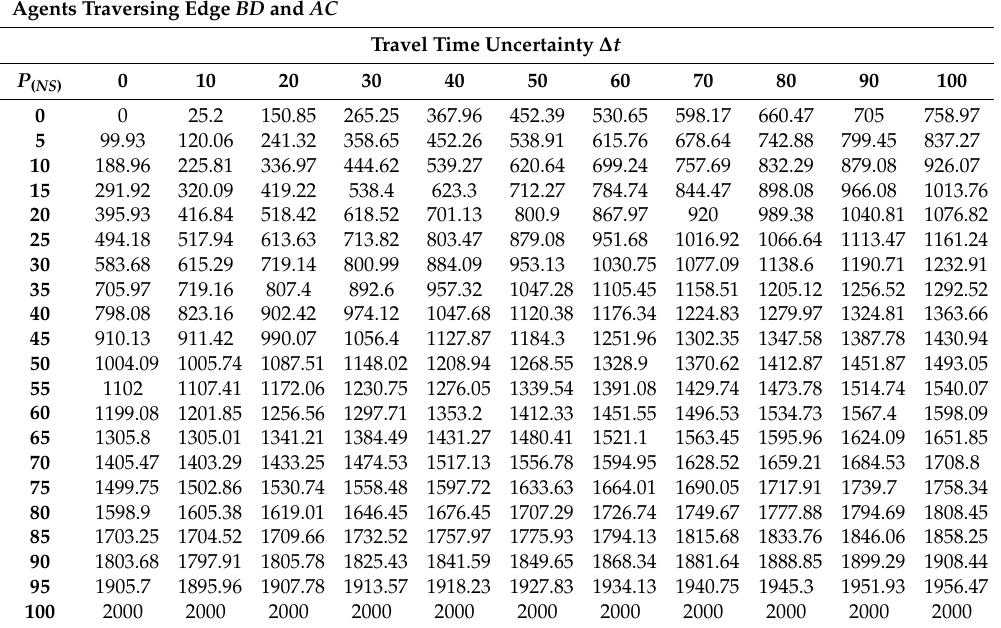
Table A2. Average number of agents traversing edge BD and AC for given values of ∆ t and P ( NS ) . Agents Traversing Edge BD and AC